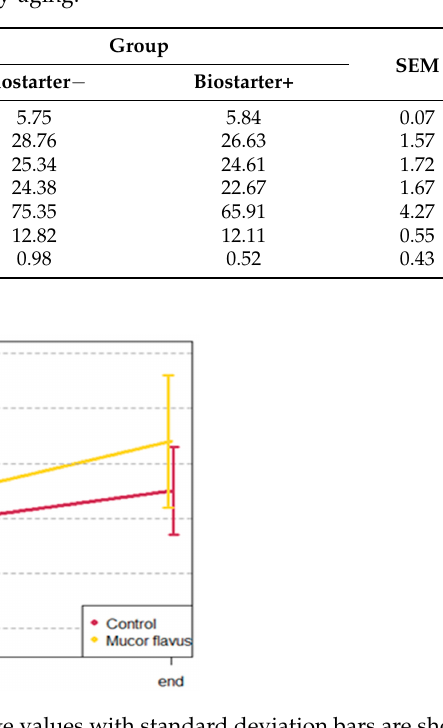
Table 2. Characteristics of beef quality after dry-aging.